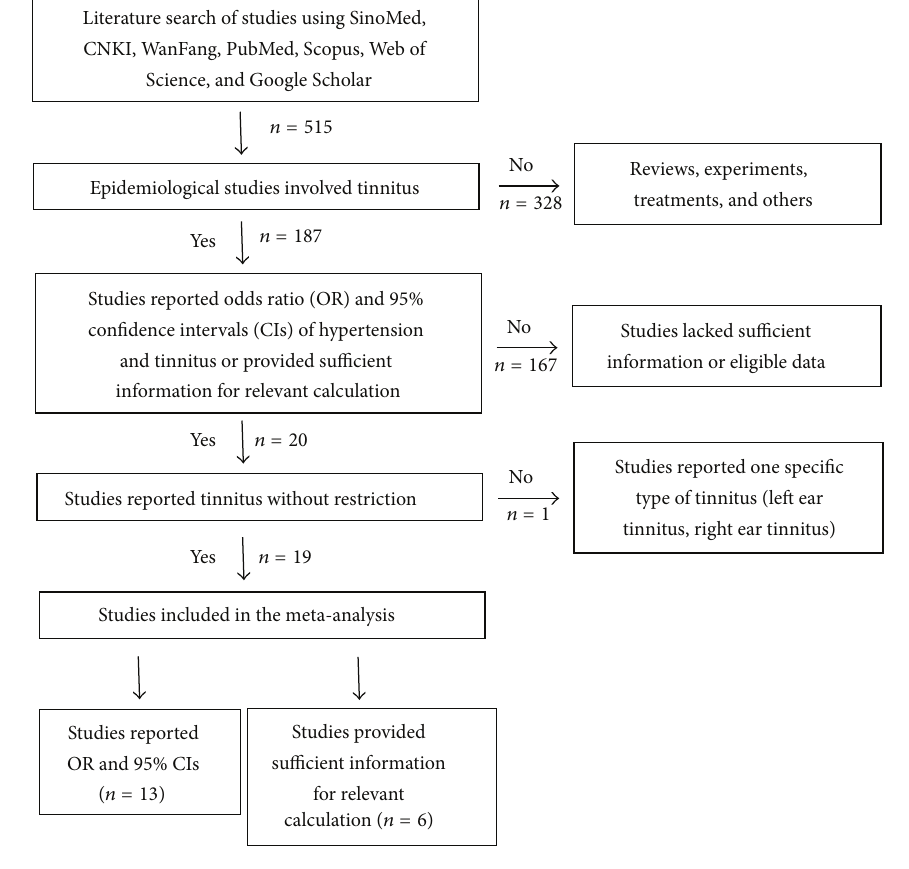
Figure 1: Flow diagram on the search process.